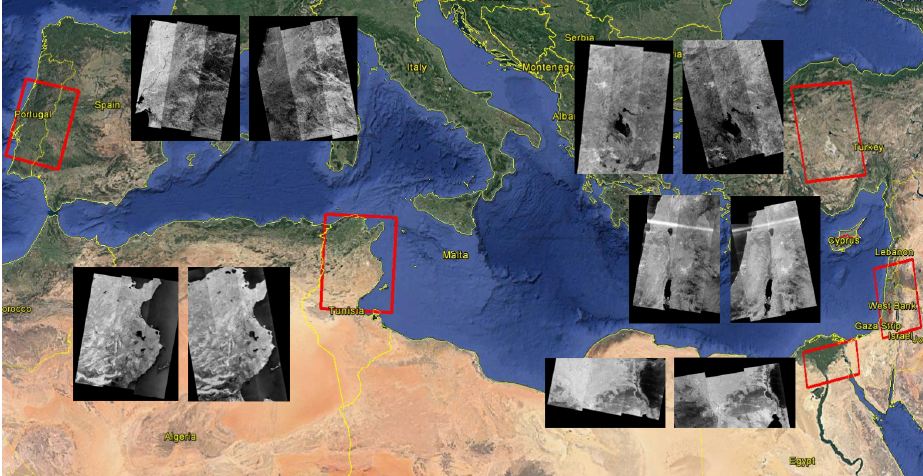
Figure 2. Locations of the five test